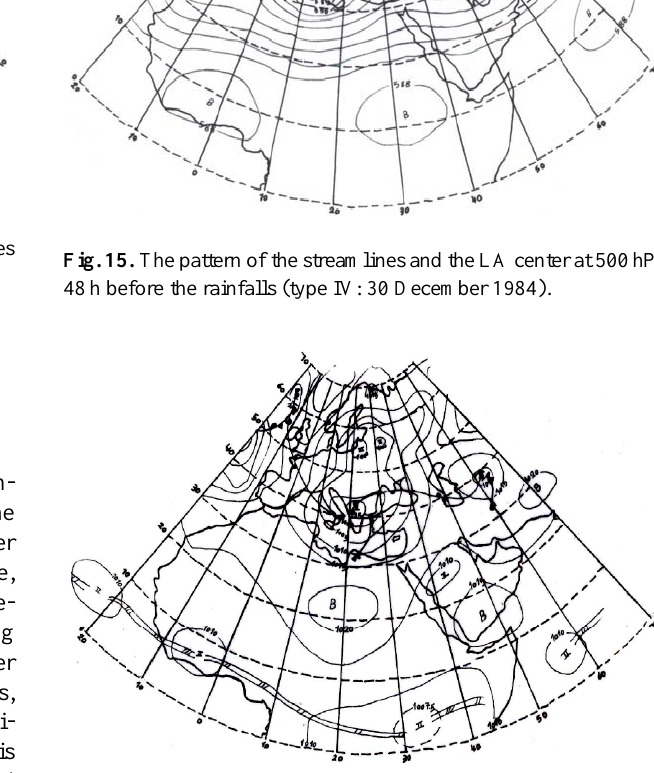
LP center during the heavy rainfalls (type IV: 3 January 1985). heavy rainfalls (Type IV: 3 January 1985)